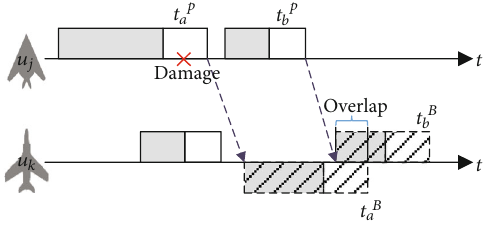
Figure 7: Illustration example for Property 7. Figure 8: Assigning modes for primary